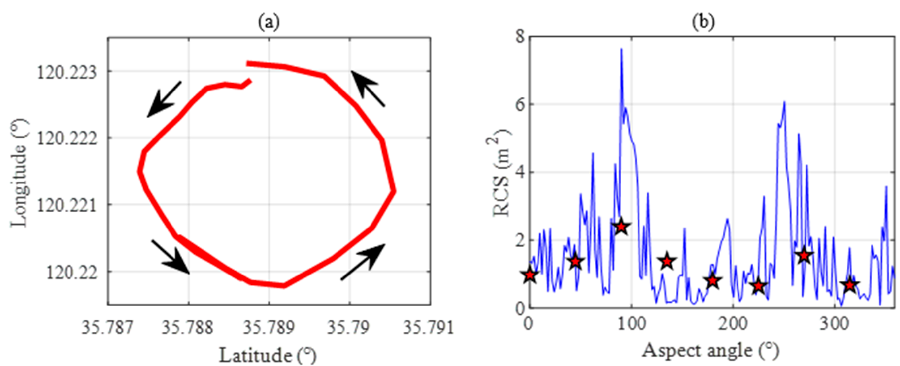
Figure 6. The GPS data and average RCS over aspect angle “windows” 2 ◦ wide from the circumferential fishing boat. ( a ) The longitude and latitude of target; ( b ) the average RCS varies with aspect angle.